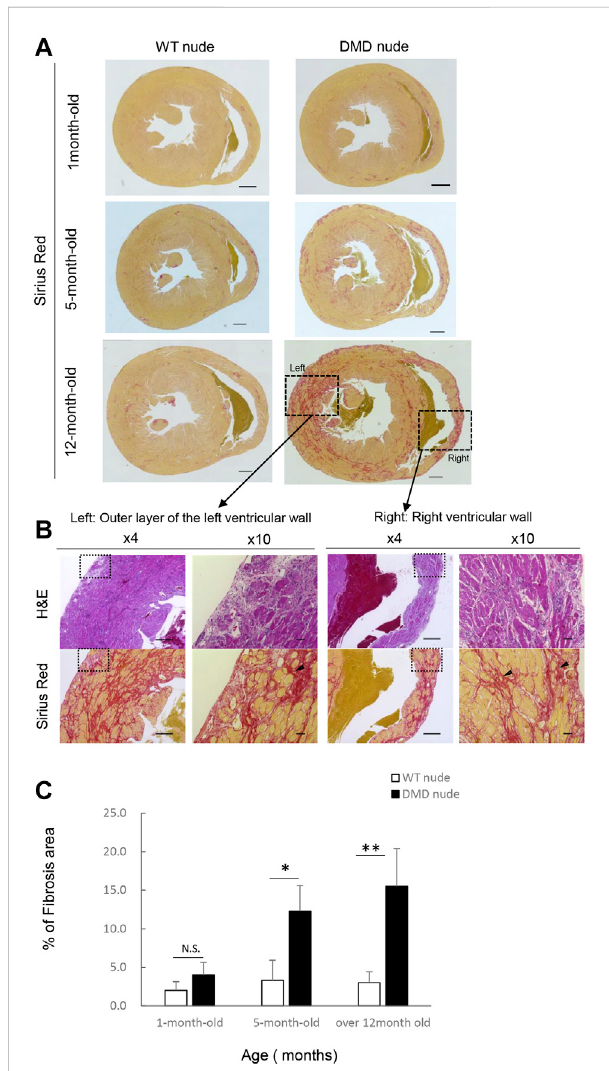
FIGURE 3 Severe and progressive muscle changes in the heart of DMD nuderats. (A) RepresentativeimagesofSiriusred(SR)-stainedheartsof WT and DMD nude rats, showing the degree of fi brosis at each respective age. WT nude rats are shown on the left, and DMD nude rats are shown on the right. Scale bar = 1 mm (one-month-old), scale bar = 500 µm (5- and 12- month-old) (B) Detailed analysis of severe and progressive changes in the heart of a DMD nude rat. The upper row shows hematoxylin & eosin (H&E) staining, and the lower row shows SR staining images. The right panel shows magni fi ed views of the left panel. Magni fi ed area denoted by the square in panel (A,B) ×4, scale bar = 500 μ m; ×10, scale bar = 50 µm. (C) Bar graph summarizing SR-positive areas in WT and DMD nude rats at 1, 5, and over 12 months of age. N.S. non-signi fi cant, * p < 0.05, ** p <